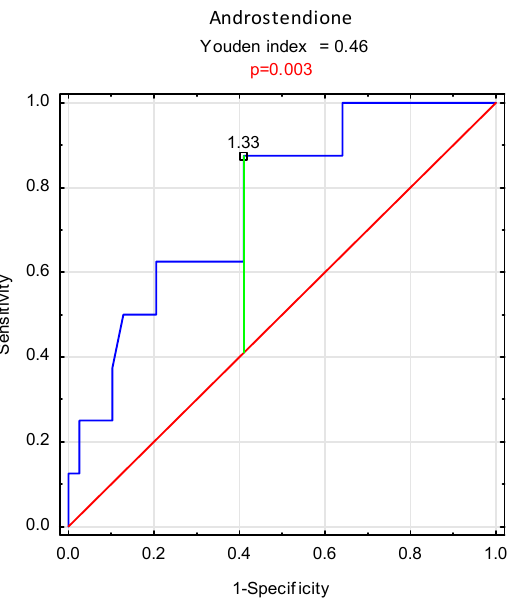
Figure 3. ROC analysis of free testosterone serum concentration in the prognosis prediction in men undergoing hemodialysis.